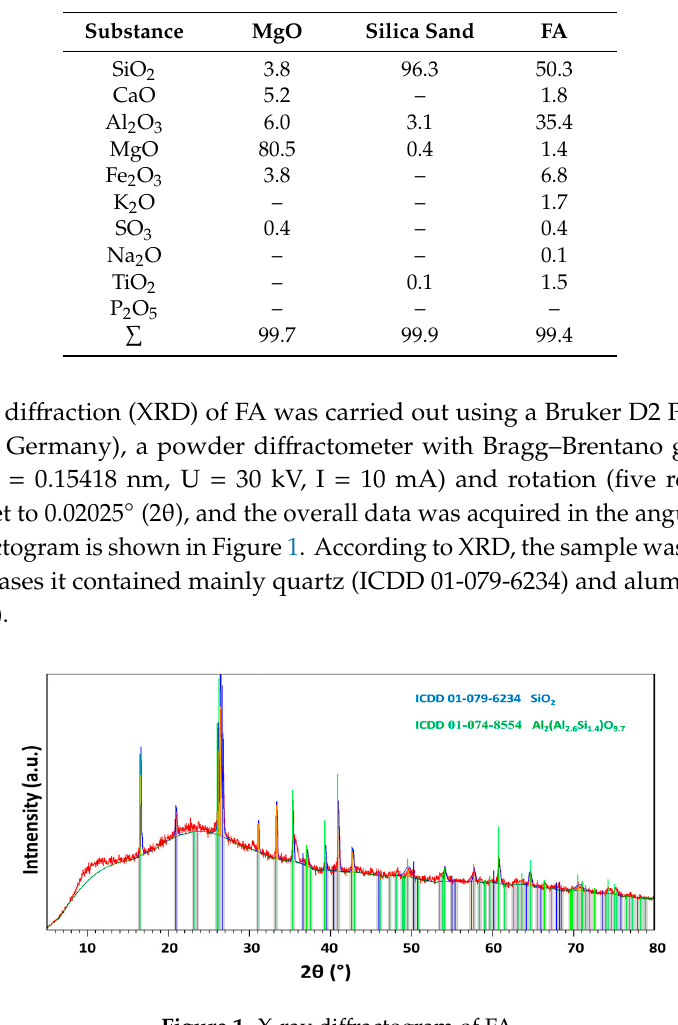
Table 1. Chemical composition of caustic MgO, silica sand, and fly ash (FA; wt %).